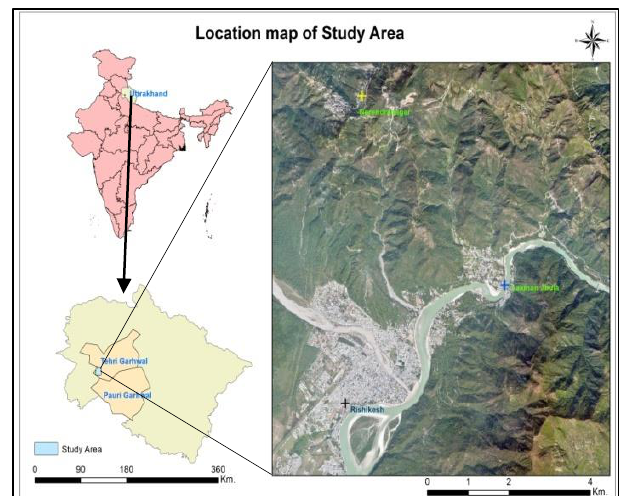
Figure 1 Study area Rishikesh, Uttrakhand.